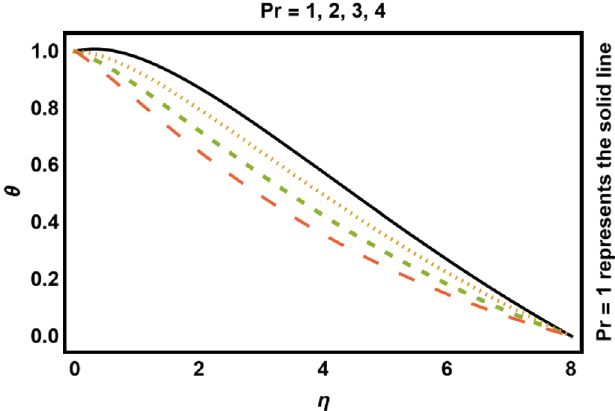
Figure 10. Pr on temperature profile.